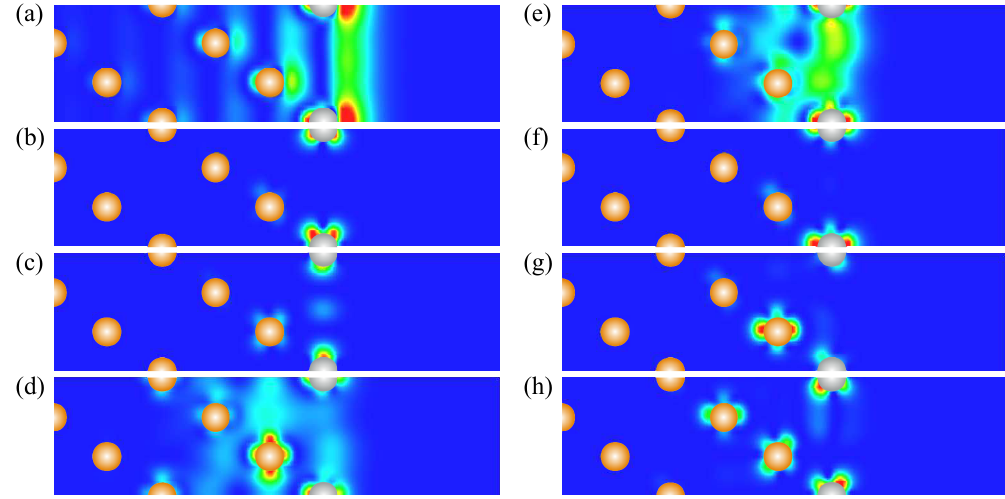
Figure 7. Charge density distribution of (a) Γ 1 , (b) Γ 2 , (c) Γ 4 , (d) M 5 , (e) M 6 , (f) K 7 , (g) K 8 , (h) K 9 surface, quantum-well, and interface states in the 1 ML-Pt/Au(111) heterostructure. The Pt and Au atomic positions are shown by grey and yellow dots,